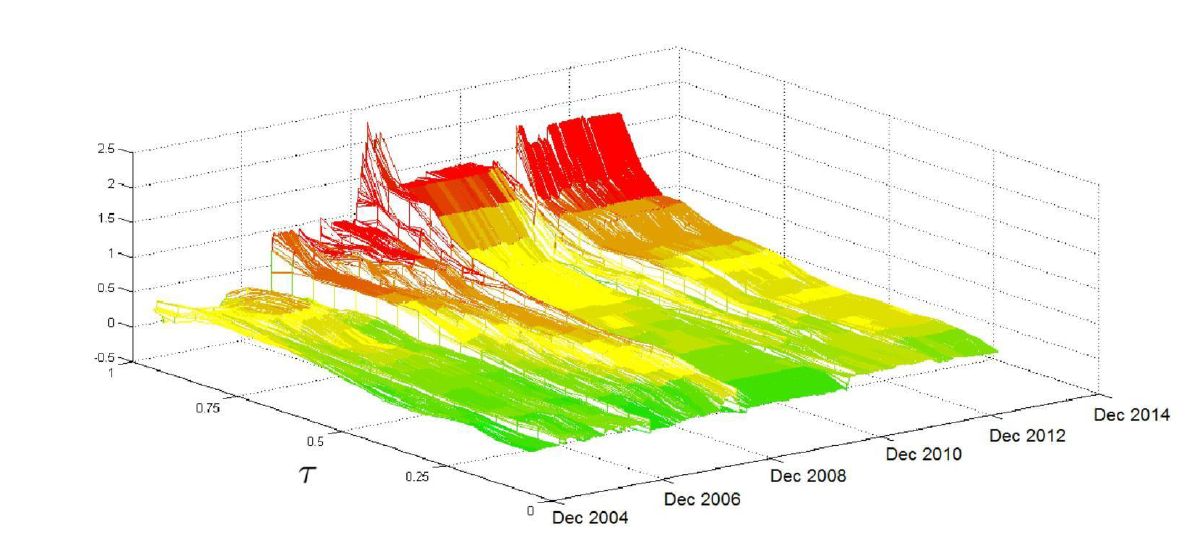
Figure 2. Rolling analysis for f pc t − 1 .